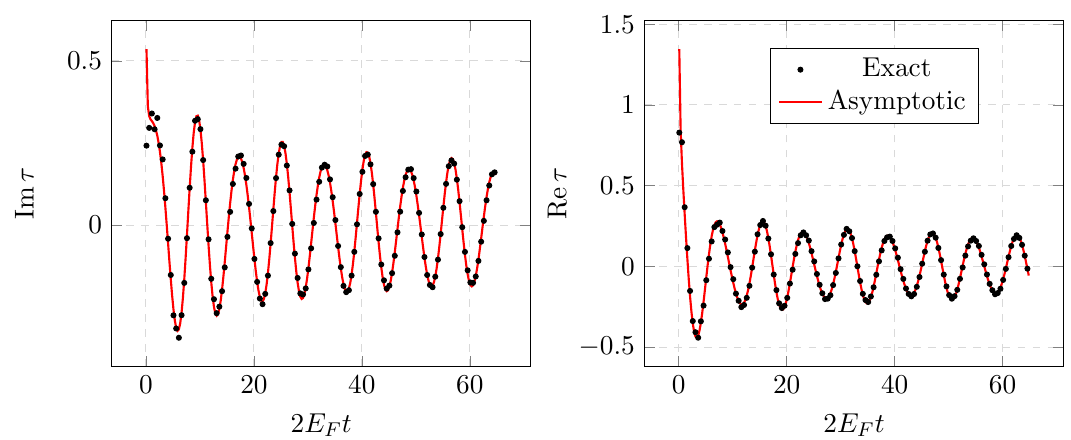
Figure 8: A comparison of the exact expression for the zero temperature tau function τ ( k t , t ) computed by the Fredholm determinant (47) at the light cone (black dots), F over the asymptotics (red solid lines) for ν = 0.4 and k